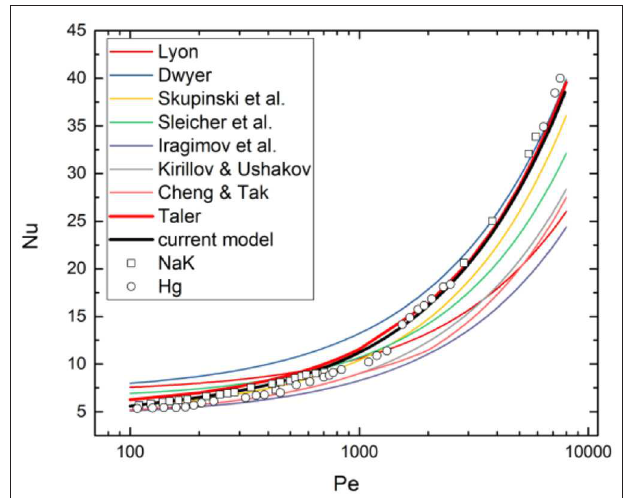
FIGURE 2 | Comparison of the Nusselt number with a different Peclet